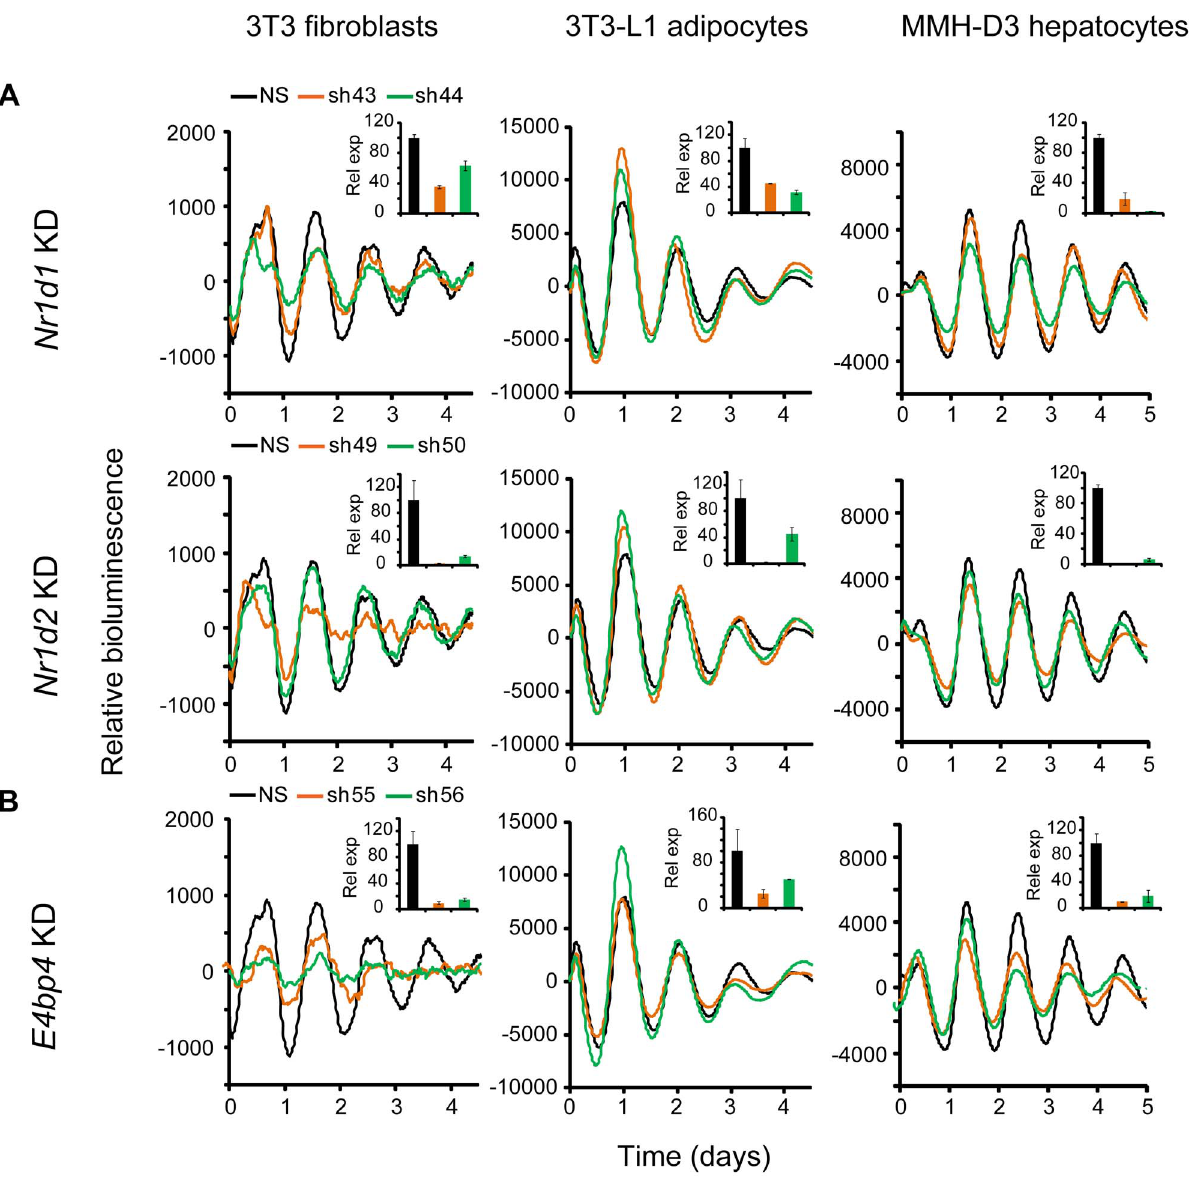
Figure 3. Knockdowns of Nr1d1 , Nr1d2 , and E4bp4 lead to cell type-specific circadian phenotypes. Bioluminescence expression patterns upon KD of Nr1d1 and Nr1d2 (A) and E4bp4 (B) in all three cell types. See Figure 2 for details. Note that, compared to the more prominent role of Nr1d1 in clock function previously found in U2OS cells or mouse behavioral rhythms [18,27,49], Nr1d2 plays a more prominent role in all three cells. E4bp4 KD caused period length and/or amplitude phenotypes depending cell